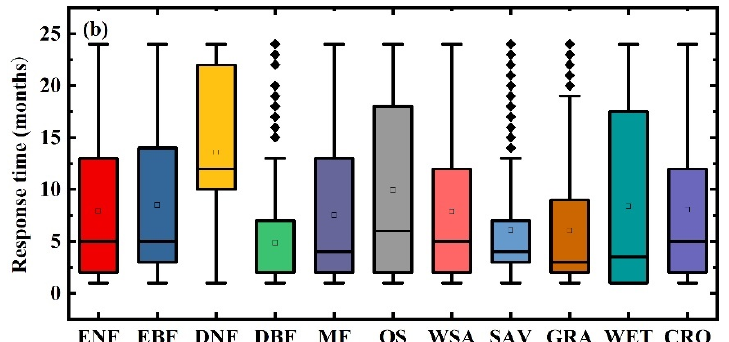
Figure 6. The correlation coefficient ( a ) and response time ( b ) of vegetation productivity to water availability in different land cover types. ENF, EBF, DNF, DBF, MF, OS, WSA, SAV, GRA, WET and CRO represent evergreen needleleaf forest, evergreen broadleaf forest, deciduous needleleaf forest, deciduous broadleaf forest, mixed forest, open shrublands, woody savannas, savannas, grasslands, wetlands and croplands, respectively. Boxes represent interquartile ranges of the values of 25 th and 75 th percentiles (Q 25 , Q 75 ), whiskers cover Q 25 –1.5×(Q 75 –Q 25 ) to Q 75 +1.5×(Q 75 –Q 25 ), horizontal lines represent the median, black empty squares represent the mean, and black solid diamonds indicate outliers.